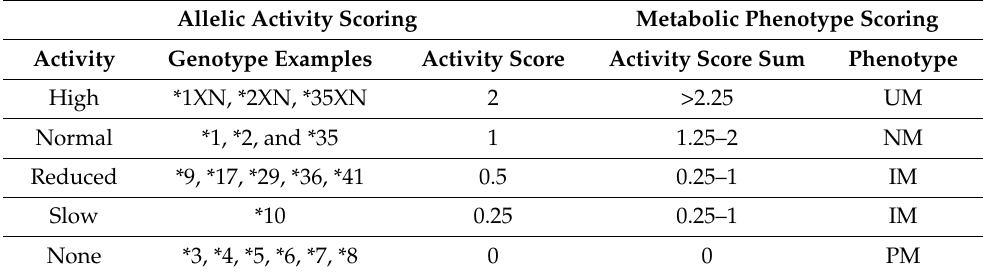
Table 2. Activity Score